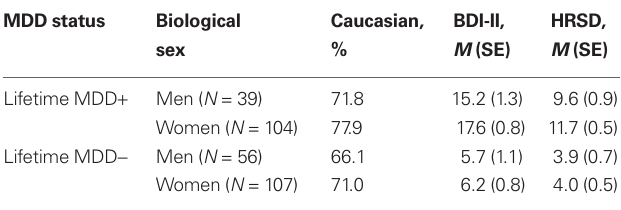
Table 1 | Participant demographics.